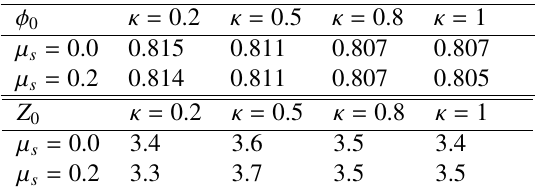
Figure 3. Bulk modulus K over E as a function of the packing fraction φ for di ff erent values of κ and for µ = 0 and 0 . 2. We also present the predictions given by Eq. (3) and the bulk modulus computed from the Platzer et al. model. Table 1. Values of φ and Z at the jammed state for the di ff erent samples of mixtures